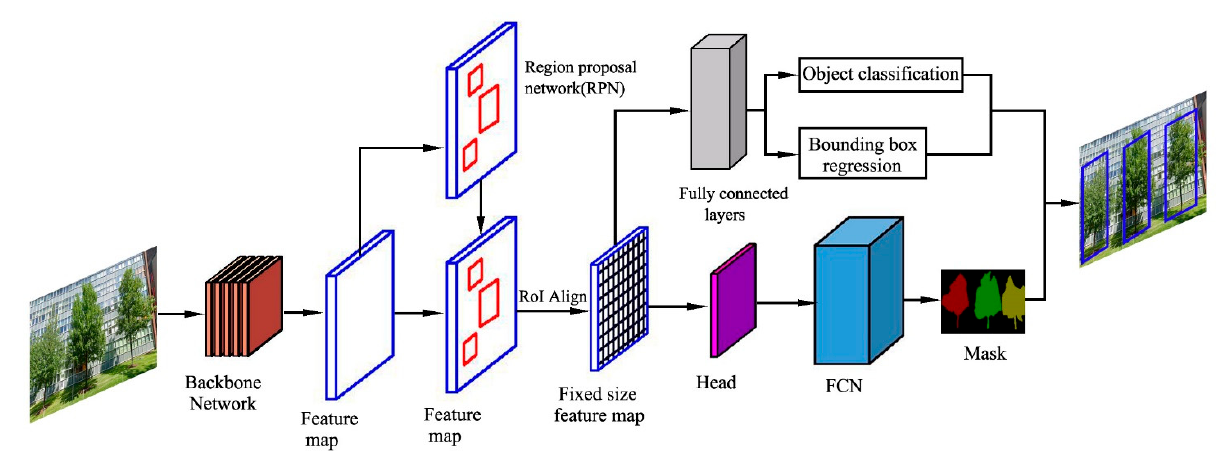
Figure 3. Urban tree detection based on Mask R-CNN and Google Street View imaging. Backbone Network refers to the image as input and extracts “feature maps”; RPN generates the proposal for object detection; RoI (region of interest) is a proposed region from the original image. RoI Align is an operation for extracting a small “feature map” from each RoI in detection and segmentation. FCN represents a fully convolutional